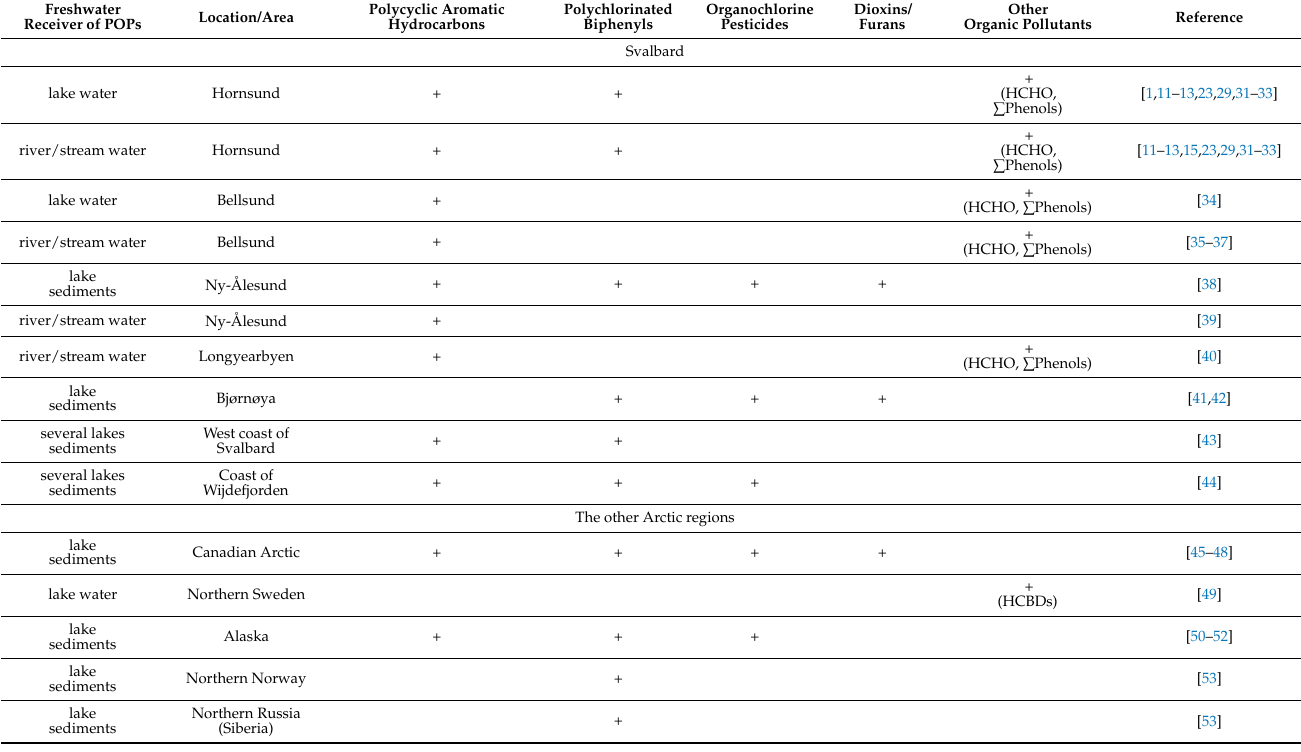
Table 1. Examples of commonly detected organic pollutants in the freshwater environment of the